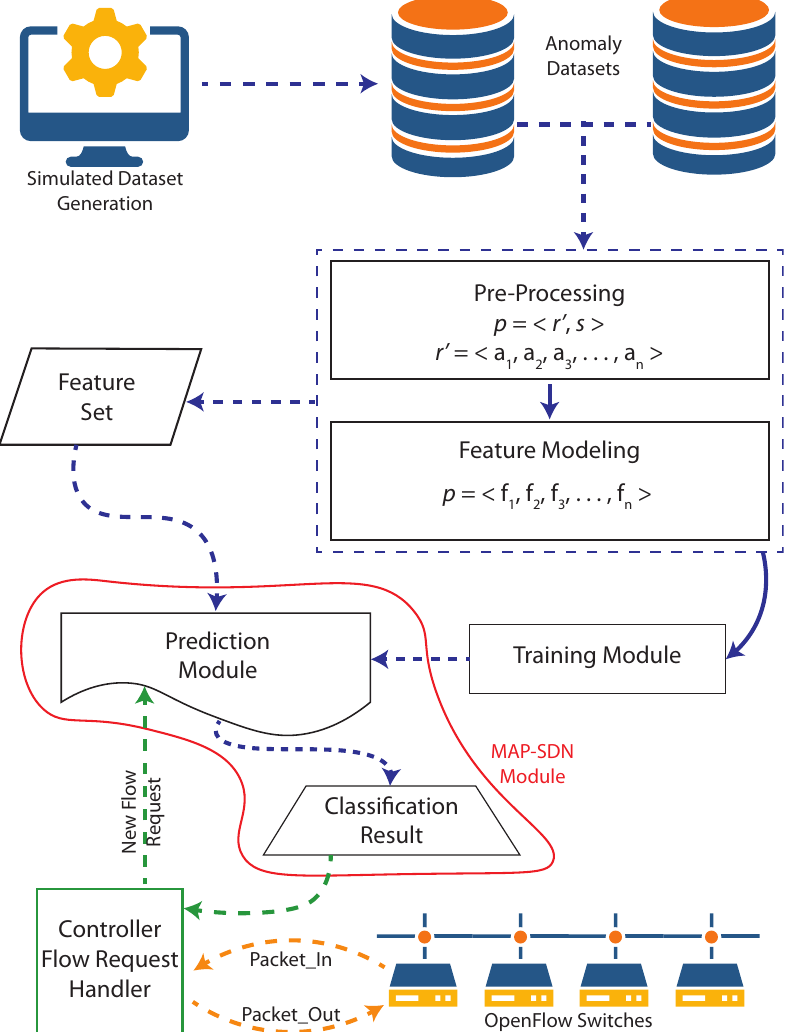
Figure 2. Overview of the proposed approach where dashed lines represent data to/from processes, and solid lines represent process-to-process